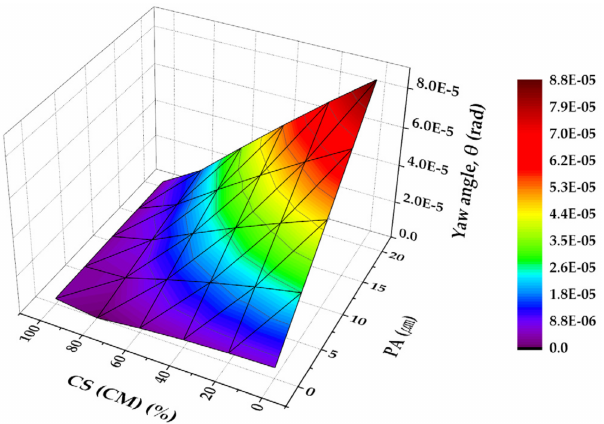
Figure 20. Yaw angle vs. CS and PA .